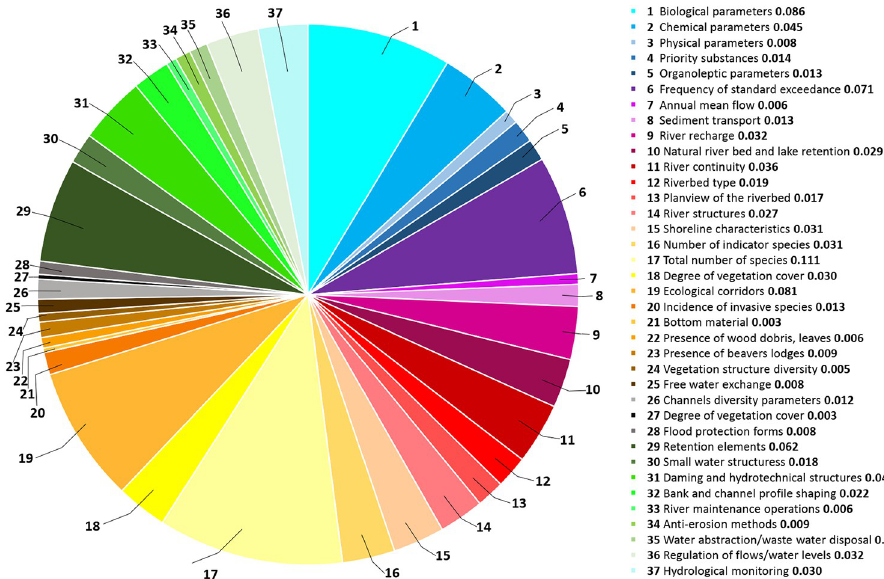
Fig 7. Global vector values of level III of the hierarchical